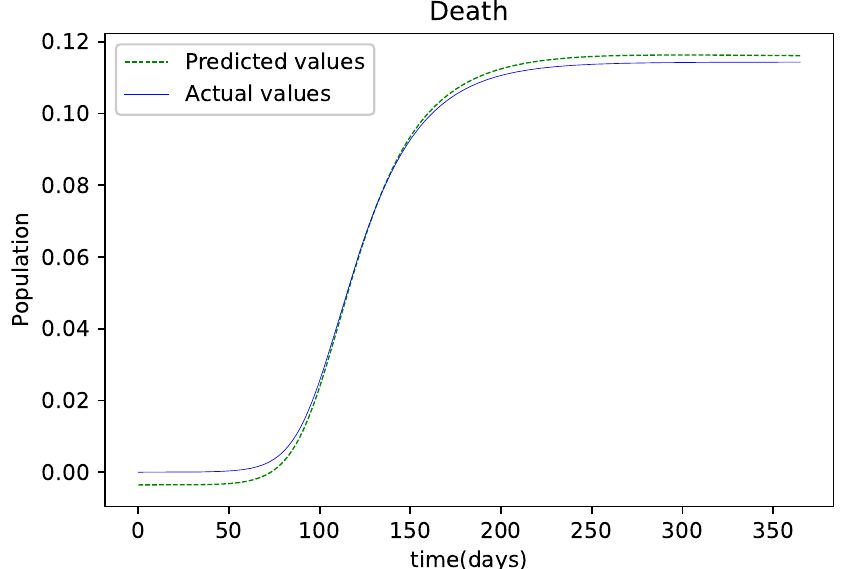
Figure 6. The resulting graph of the predicted values of the Deceased population and the actual values of the deceased population from the Mathematica generated